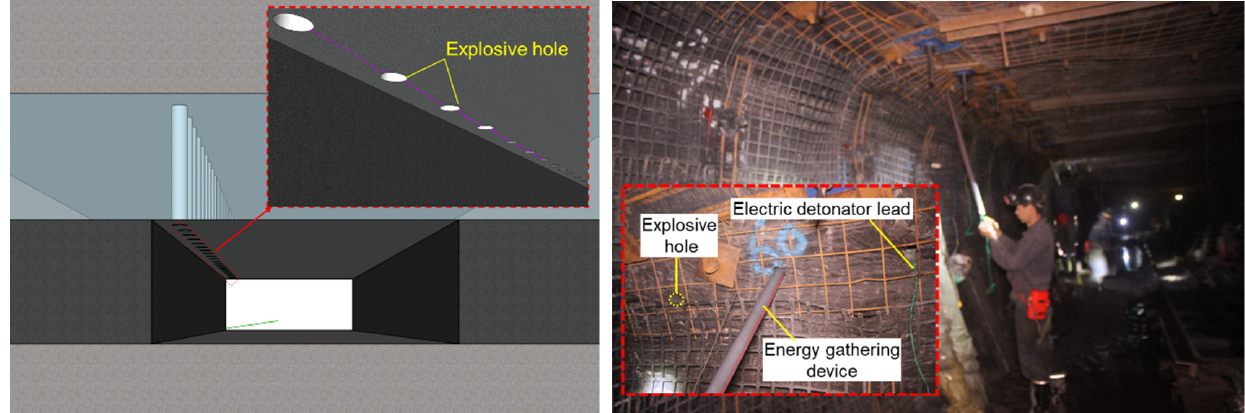
Figure 8. Layout of roof cutting blast holes.